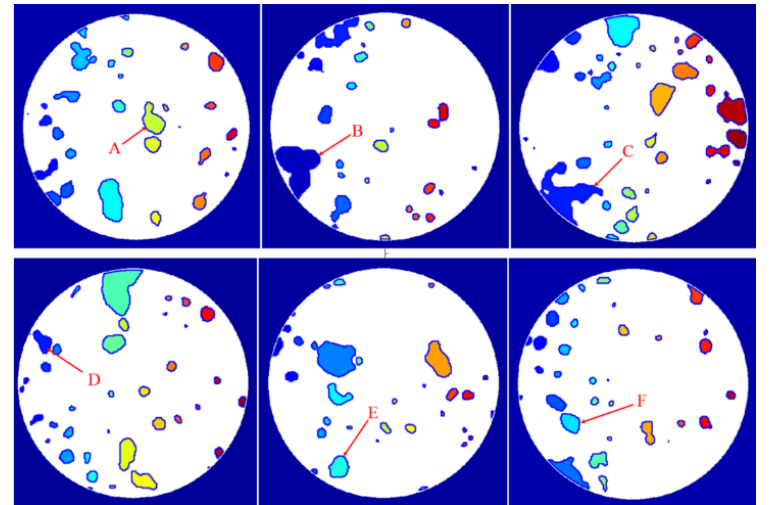
Figure 11. Diagram of hole location and number.